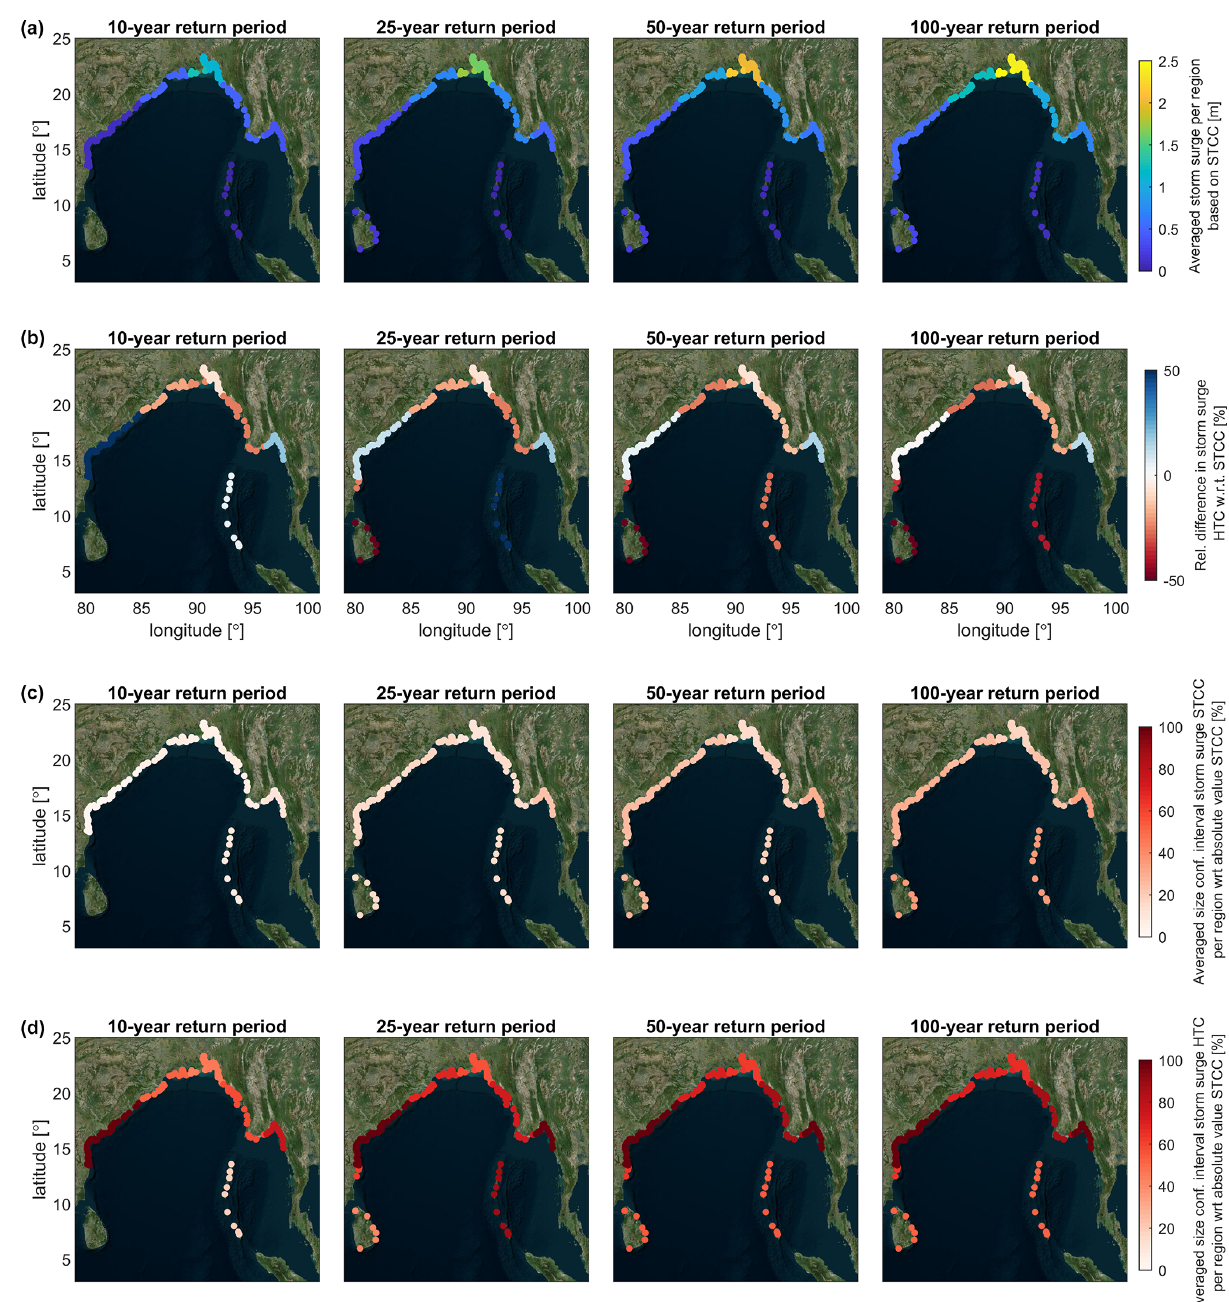
Figure 12. (a) Regionally averaged storm surges along the Bay of Bengal estimated based on STCC for return periods of 10, 25, 50 and 100 years. (b) Regionally averaged relative difference (in %) of storm surges estimated based on HTCs compared to STCC of panel (a) . (c) Regionally averaged size of confidence interval of storm surge based on STCC as a percentage (%) of the absolute value of STCC of panel (a) . (d) Regionally averaged size of confidence interval of storm surge based on HTCs as a percentage (%) of the absolute value of STCC of panel (a)